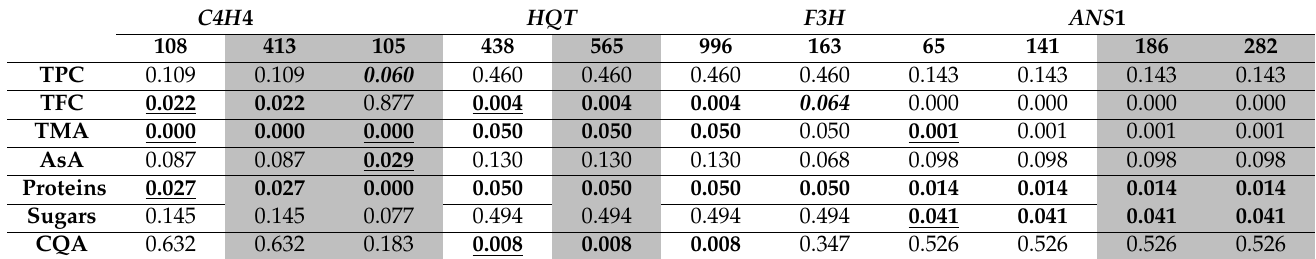
Table 4. X 2 contingency table. In the first row, enzyme names along with the observed SNP’s positions (second row) are shown. The left column shows the phytochemicals that were examined for correlation with the above-mentioned SNPs. The columns in grey represent SNPs leading to synonymous mutations, while the rest to missense mutations. The numbers in bold show the statistically significant correlations ( p < 0.05), while those in italics have p -values close to 0.05. Underlined numbers represent significant correlation values also observed in the logistic